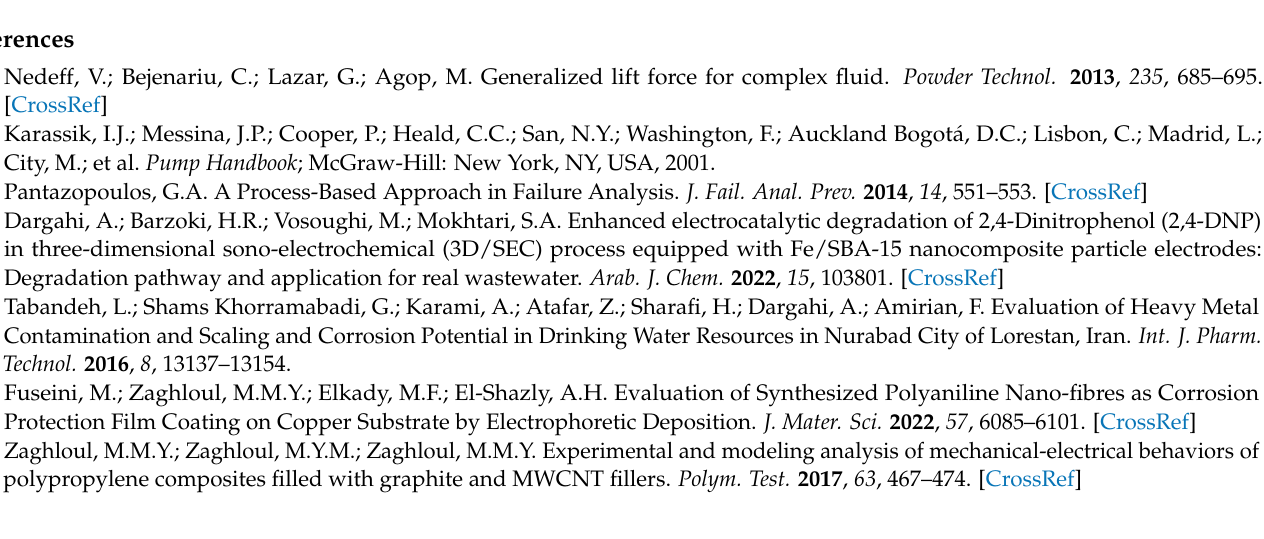
Figure S10: The Nyquist and Bode diagram after 90 days of immersion in DWWW-2; Figure S11: The Nyquist and Bode diagram after 90 days of immersion in